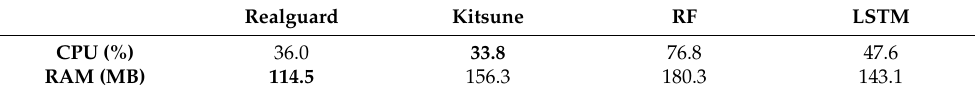
Table 7. Compare resource consumption on Rasp Pi between Realguard and